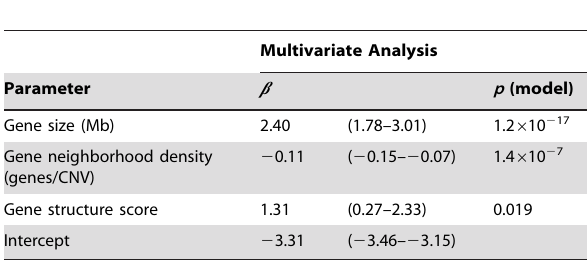
Table 2. CNV-propensity score